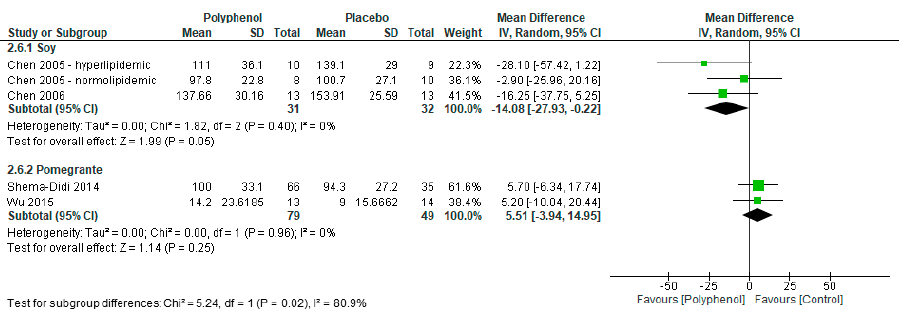
Figure 8. Sensitivity analysis of polyphenol-rich interventions on LDL-C.